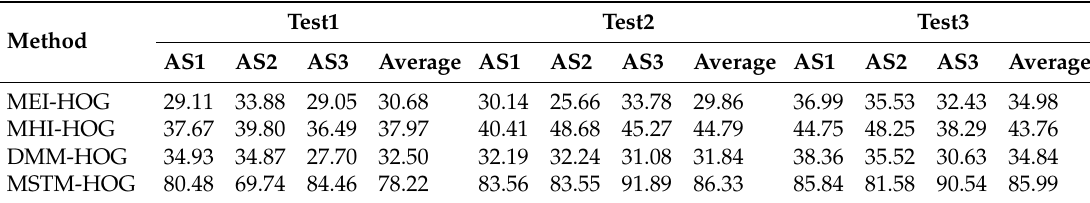
Table 4. The recognition rates (%) of different methods on D2.